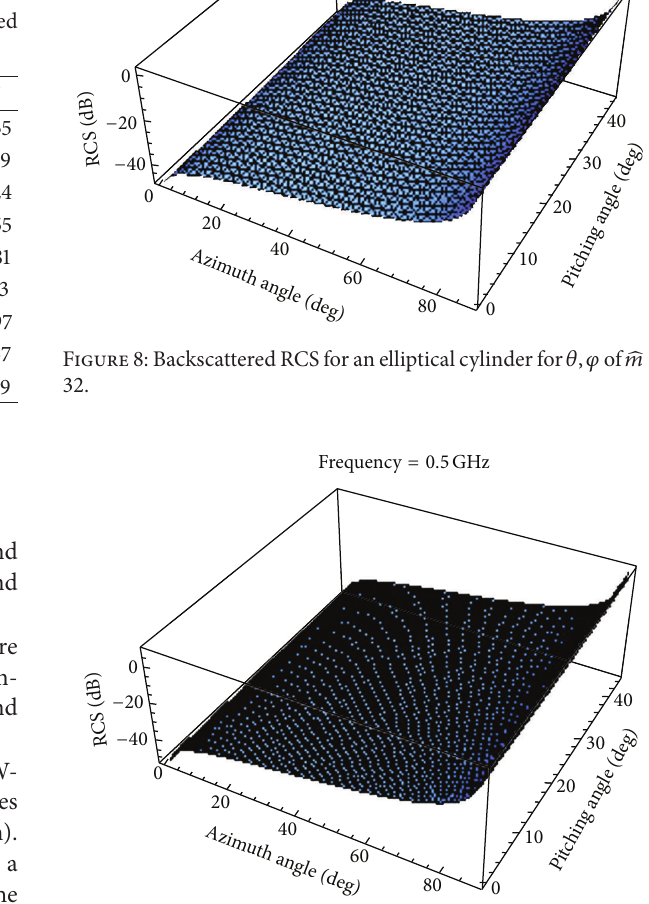
Figure 9: Backscattered RCS for an elliptical cylinder for 𝜃,𝜑 of ̂𝑚 =